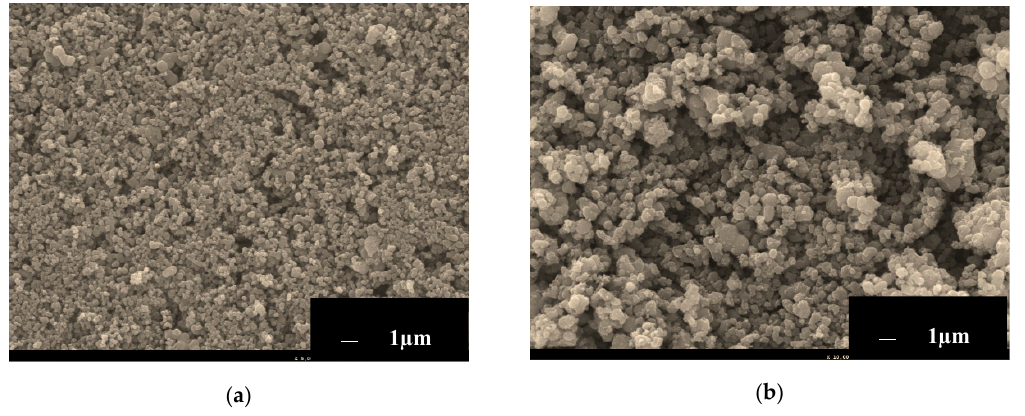
Figure 9. SEM images of magnetic core-shell Fe 3 O 4 /TiO 2 /[FeCl 2 { κ 3 - HC(pz) 3 }]: ( a ) after reaction under conventional thermal heating; ( b ) after reaction under microwave irradiation.